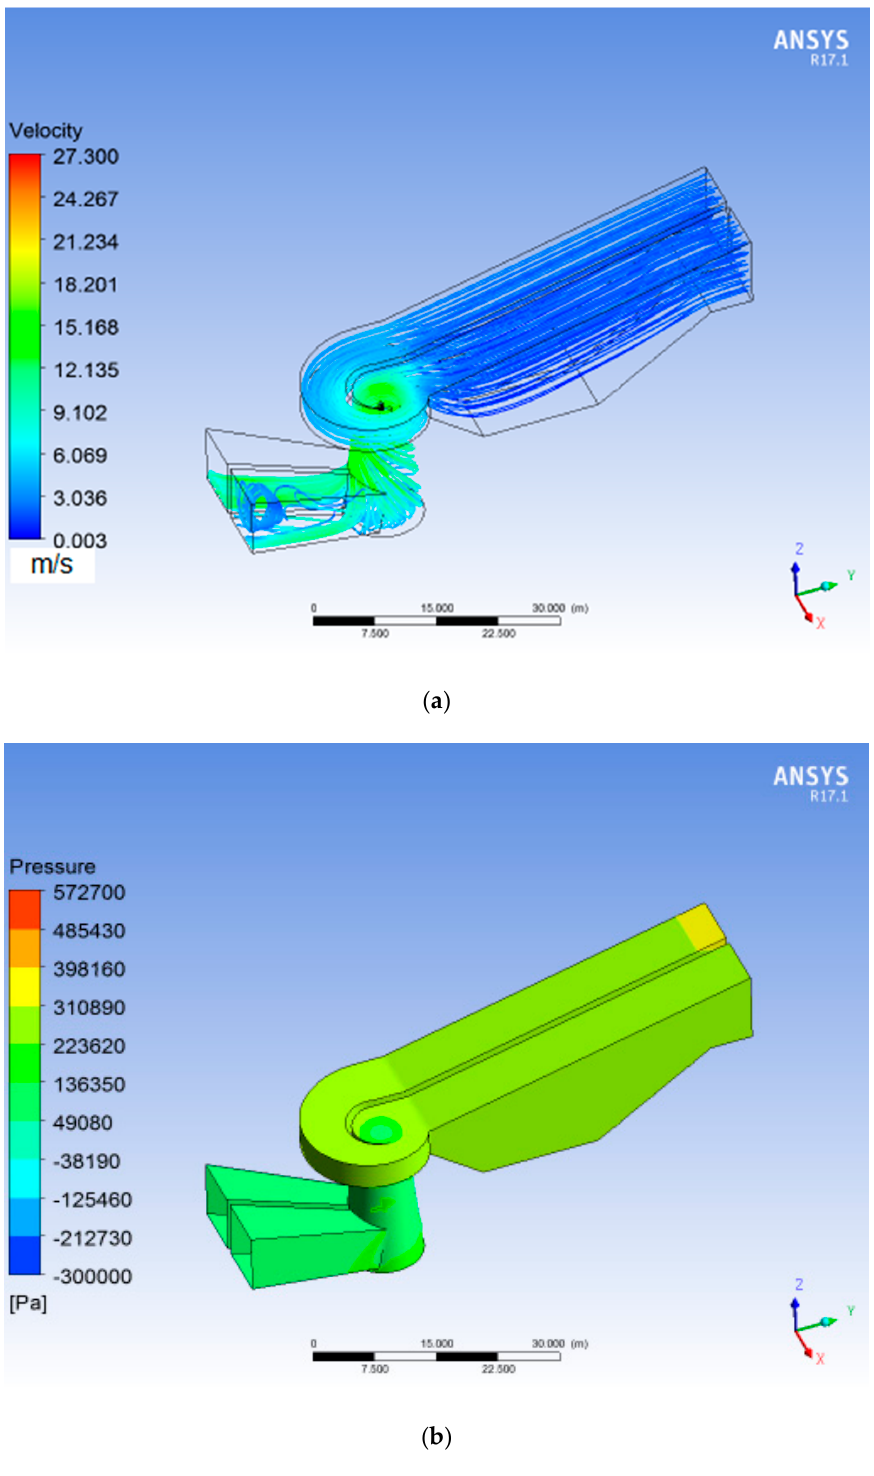
Figure 5. Example of the graphical presentation of ( a ) the velocity flow lines and ( b ) the pressure distribution in the Haditha turbine unit.